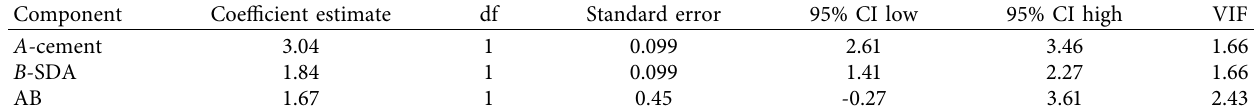
Table 21: Model coefficients calculation results for flexural strength response.